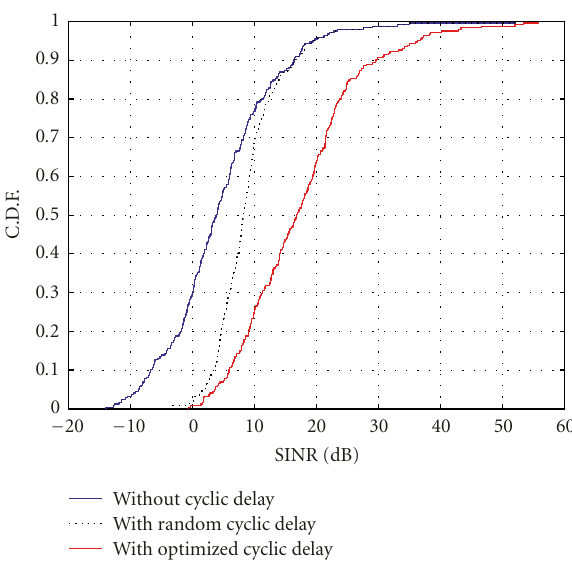
Figure 12: Cumulative distribution function of the received SINR on an urban environment with a cell radius of 500 m.